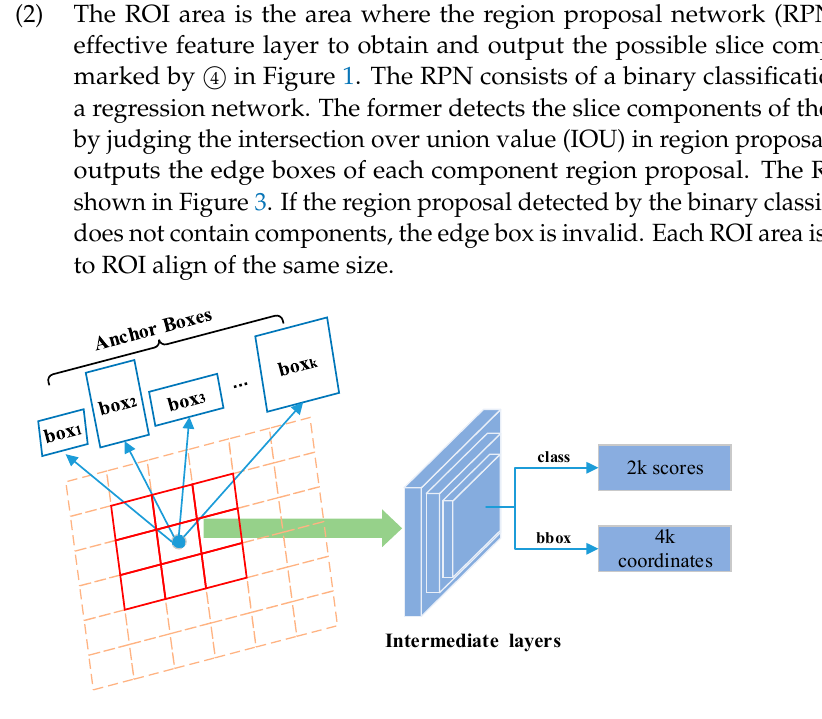
Figure 3. Region proposal network.